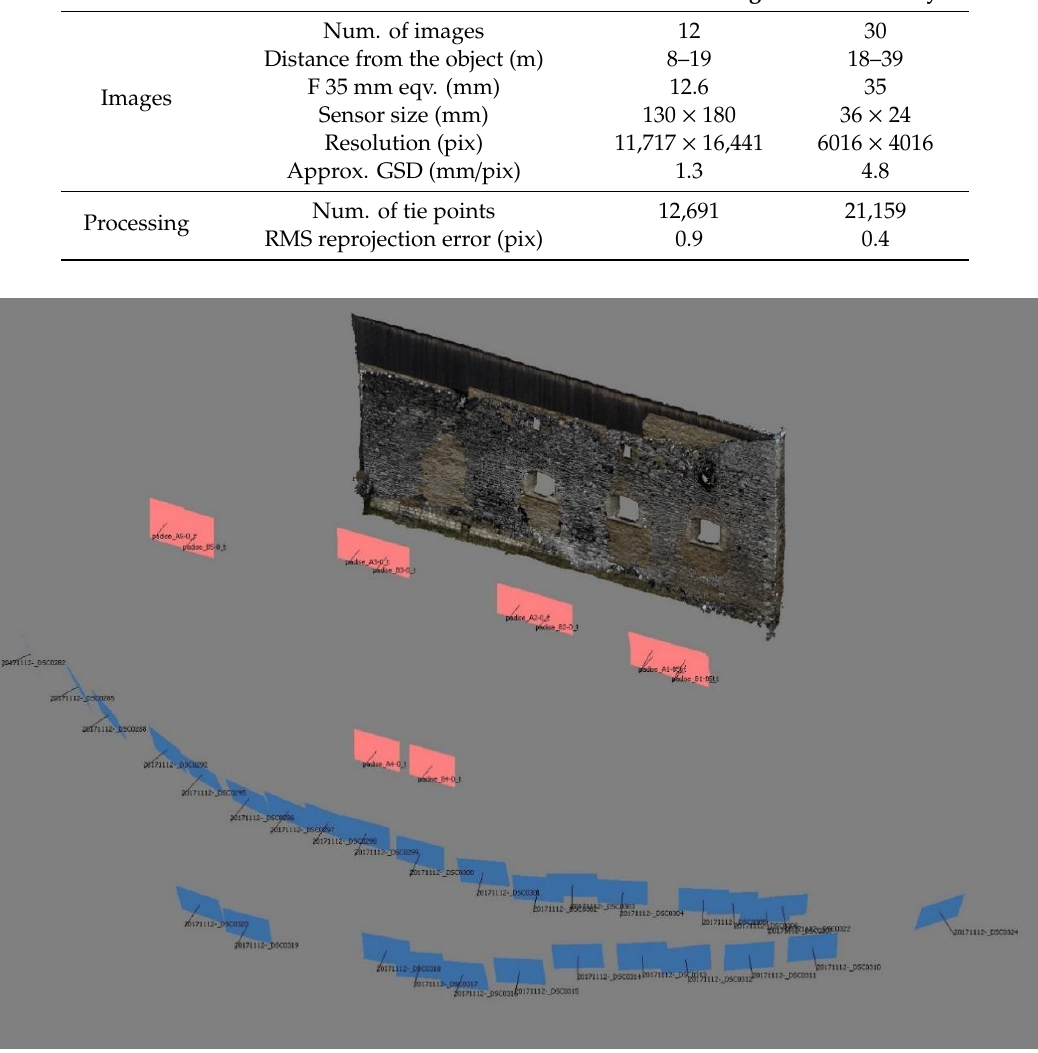
Figure 8. Merged point clouds of the re-processing and the new survey. On the figure, it is possible to observe different capturing scenarios (the highlighted images belong to re-processing). Table 5. Comparison of datasets of the re-processing and the new survey.